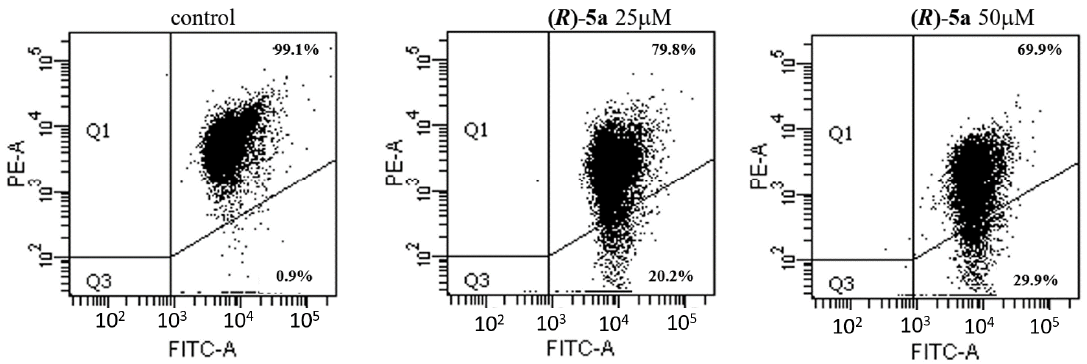
Figure 2. Mitochondrial transmembrane potential in A2780 cells treated with ( R )-5a at indicated concentrations. A representative experiment is shown.